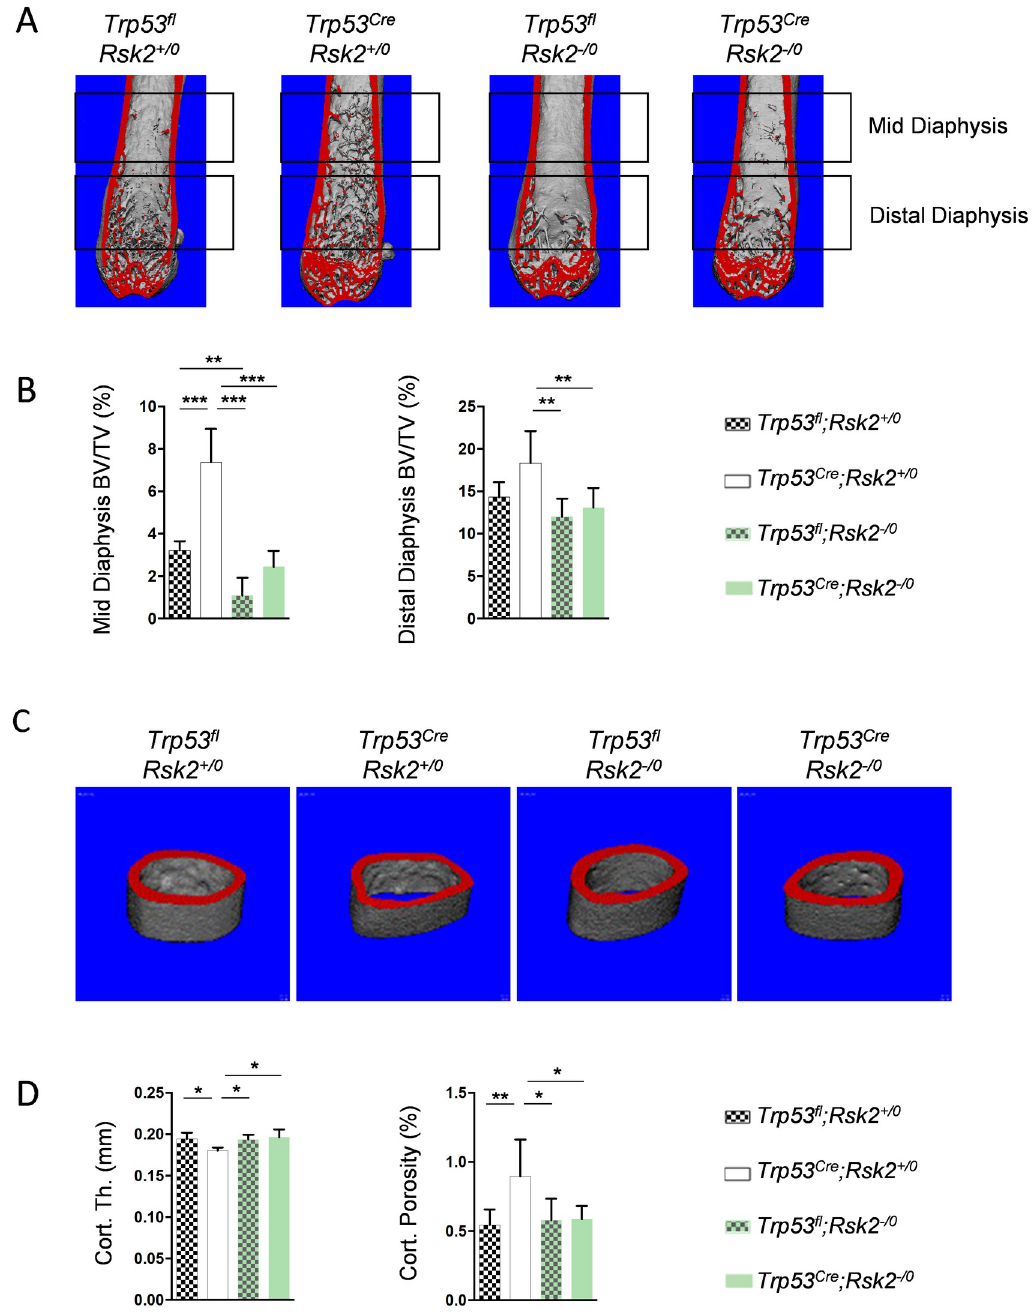
Fig 2. Trp53 Cre mice display increased trabecular bone mass in the femur diaphysis. (A) Representative μ CT images of femora from 6-month-old male mice with the indicated genotypes. The highlighted regions were separately analyzed. (B) Quantification of the trabecular bone volume per tissue volume (BV/TV) in the mid diaphysis (left) and the distal diaphysis (right) in 6-month- old male mice with the indicated genotypes. (C) Representative μ CT images of the femoral midshaft from the same mice. (D) Quantification of cortical thickness (Cort. Th.) and porosity (Cort. Por.) in the same mice. Data represent mean ± SD (n � 6). Asterisks indicate statistically significant differences ( � p < 0.05, �� p < 0.005, ��� p < 0.0005).